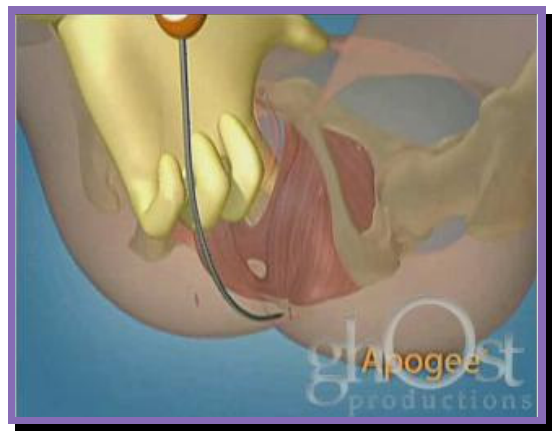
FIGURE 9. Apogee needle